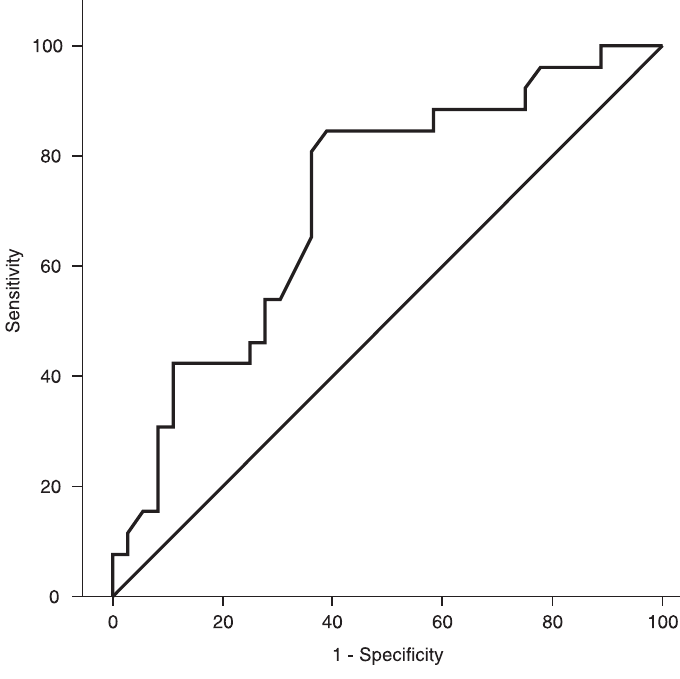
Figure 1. Accuracy of the brachial artery reac- tivity test in recognizing obstructive coronary artery disease evaluated by a receiver operating characteristic curve (area under the curve = 0.72 ± 0.06). On the basis of these data, endothelial dysfunction was defined as flow-mediated dila-